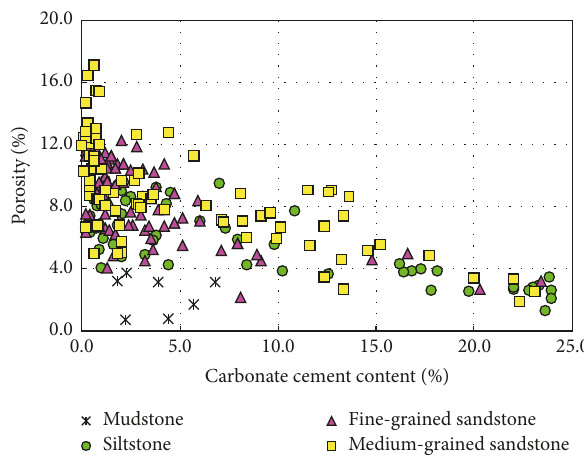
Figure6:Core-measuredporosityplottedagainstcarbonatecement content of various